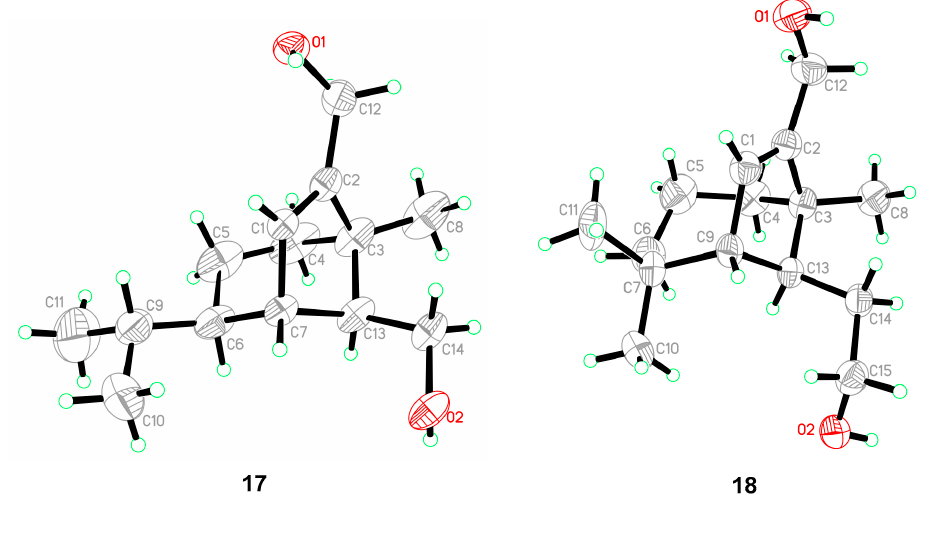
Figure 6 . ORTEP diagrams of 17 and 18 . Figure 6. ORTEP diagrams of 17 and 18 . Table 6. Inhibitory effects of the isolates against five plant pathogens (MIC, µ g/mL) a